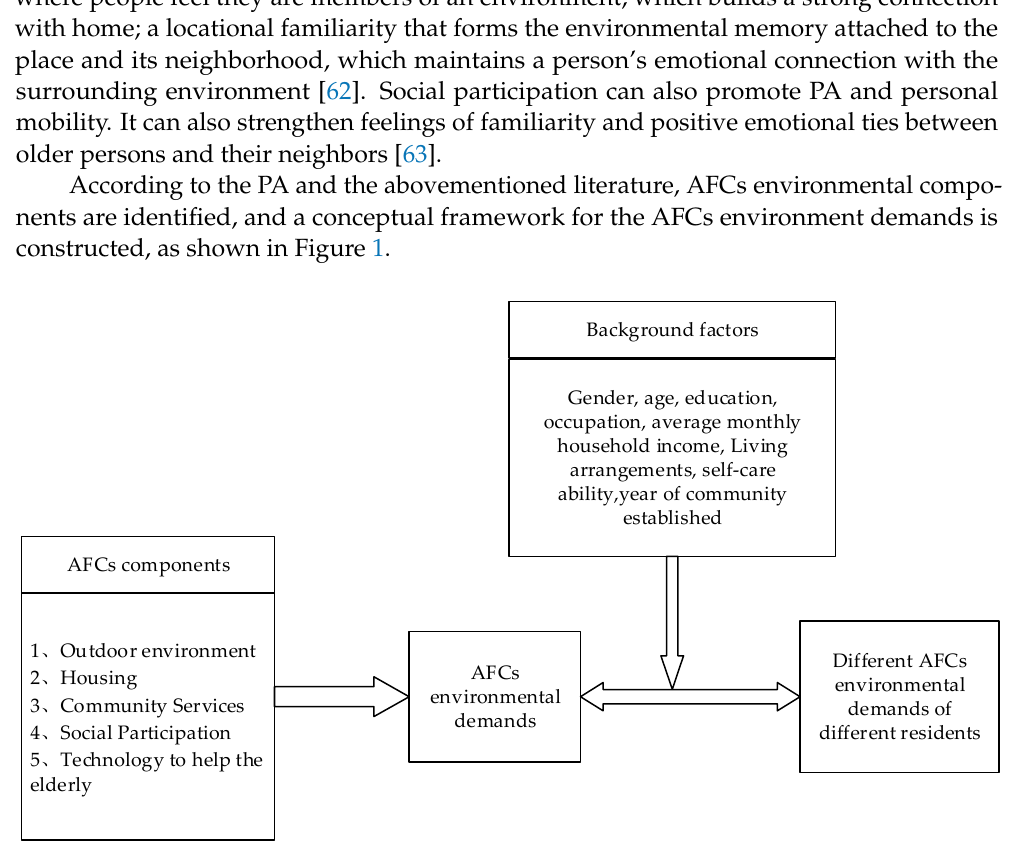
Figure 1. A conceptual framework for AFCs’ environmental demands.